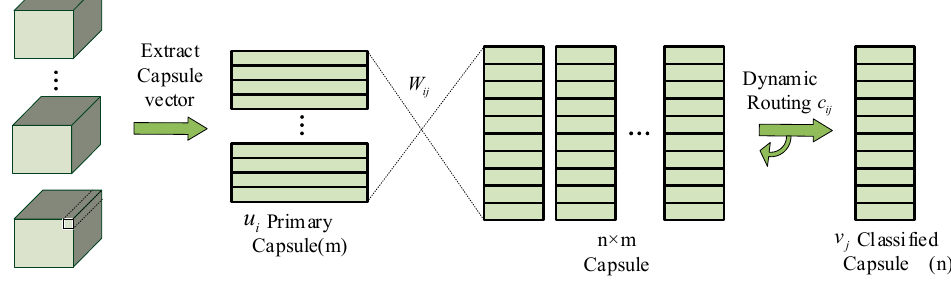
Figure 3. Schematic diagram of dynamic routing.